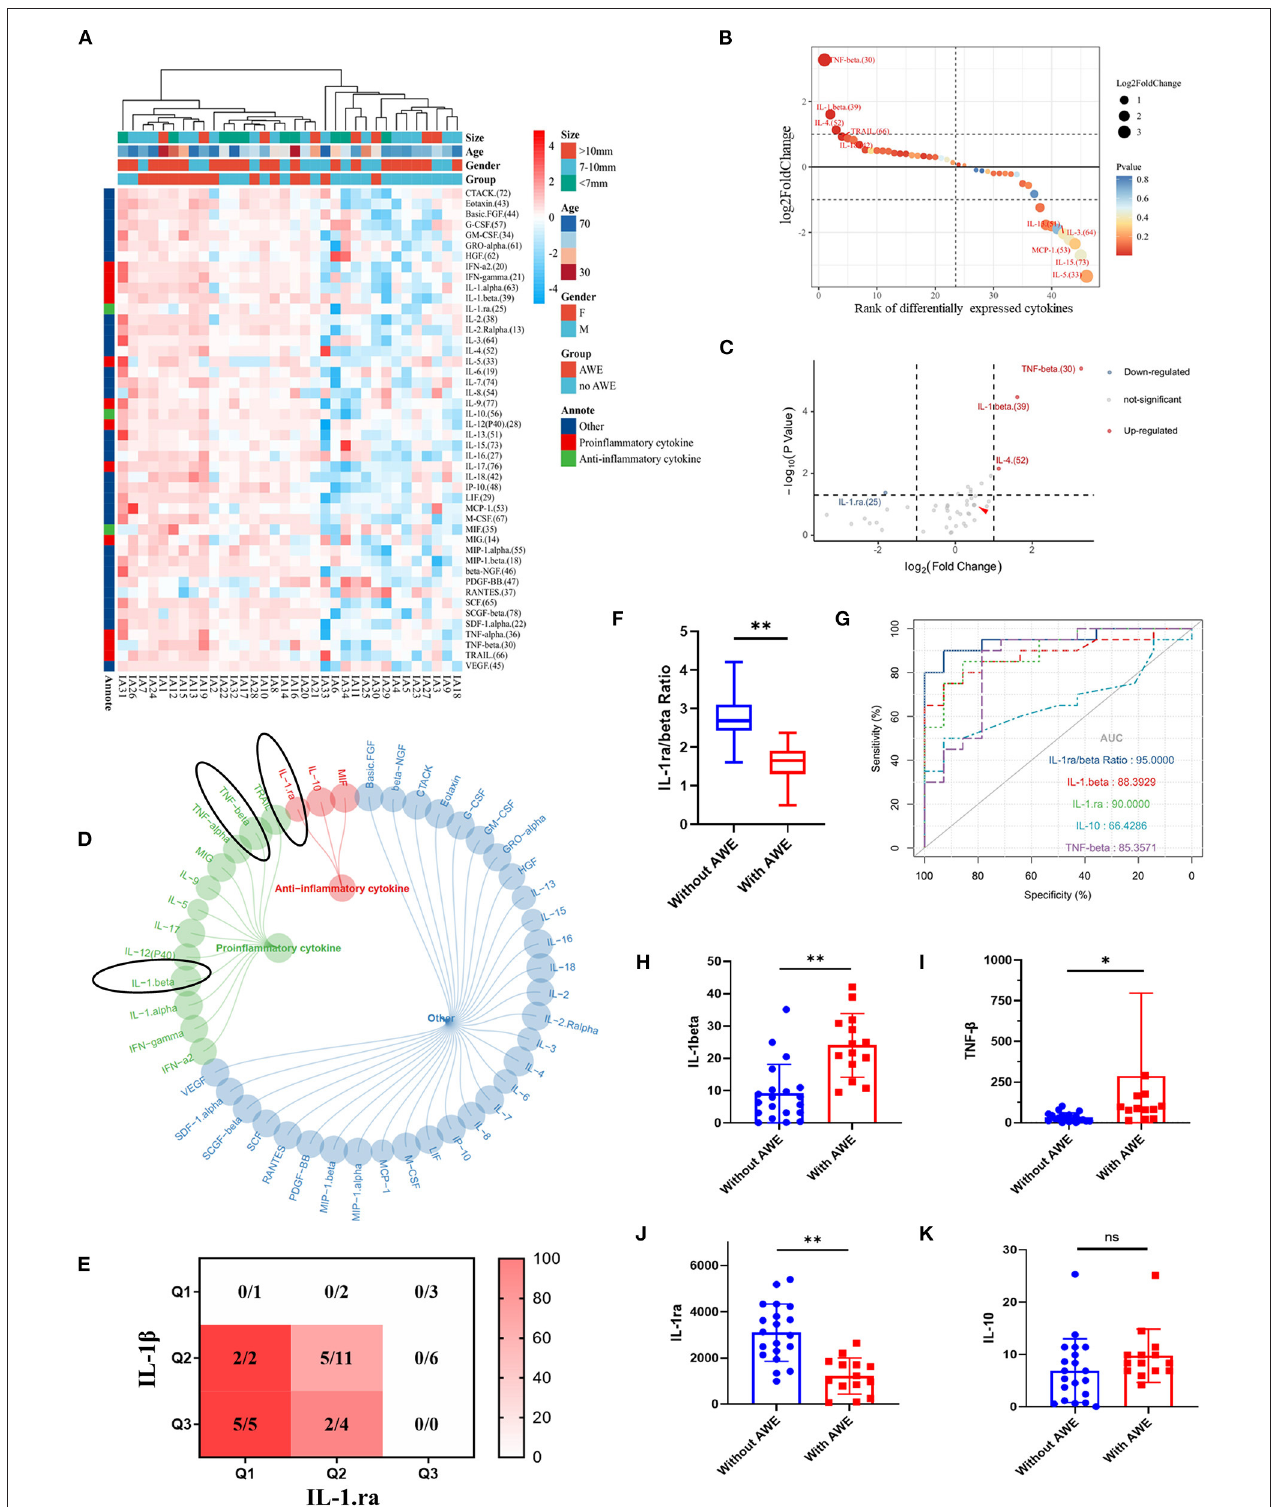
FIGURE 2 | The serum cytokines between UIAs with and without AWE. (A) The heatmap of serum cytokines between UIAs with and without AWE. Forty-six serum cytokines were identified in this study. (B) The proinflammatory cytokines were up-regulated in patients with AWE UIAs, whereas the anti-inflammatory cytokines were up-regulated in patients without AWE UIAs. (C) The volcano plot of the different cytokines in respect of UIAs with and without AWE. FC > 2 and P -value < 0.05 were adopted to identify the significantly different cytokines. IL-1 β , TNF- α and IL-4 were signnificantly up-regulated, whereas IL-1.ra was significantly down-regulated,